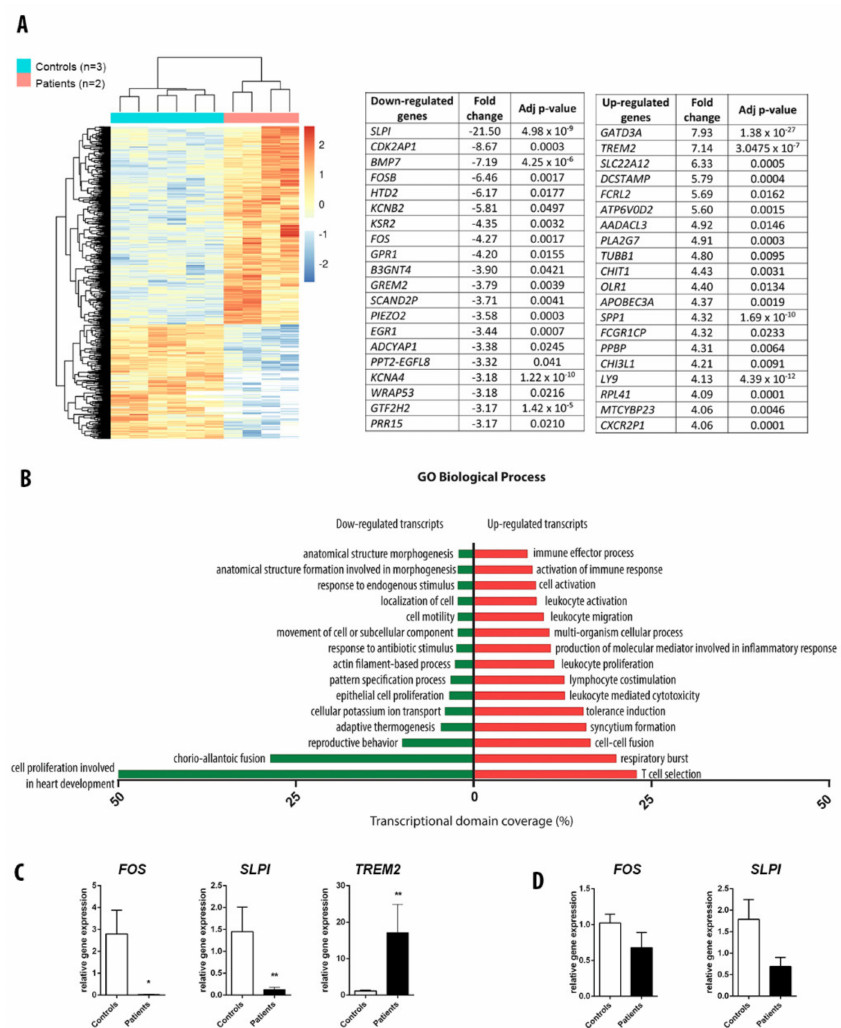
Figure 4. RNAseq on whole adipose tissue biopsies. ( A ) Heat-map and top-20 of deregulated genes in the two patients with LMNA mutations compared to three controls paired for age and sex. ( B ) GO analysis showing the main pathways deregulated in patients with lamin A mutation. ( C ) Validation by RT-qPCR of three regulated genes in controls and patients ( TREM2, SLPI, FOS ) in adipose tissue, * p < 0.05 vs. controls; ** p < 0.01 vs. controls. ( D ) RT-qPCR of SLPI and FOS in fibroblasts. TREM2 was not expressed in